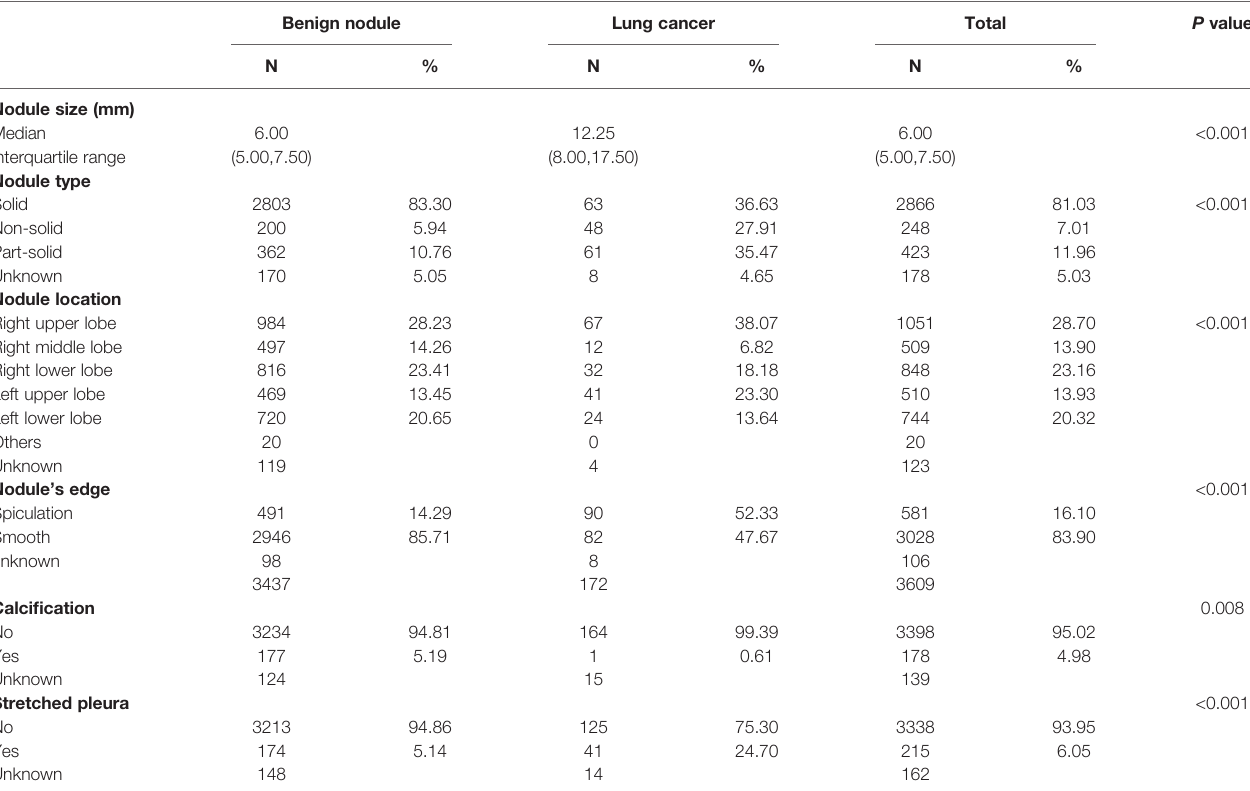
TABLE 3 | Distribution of nodule characteristics in lung cancer screening in Hebei province,